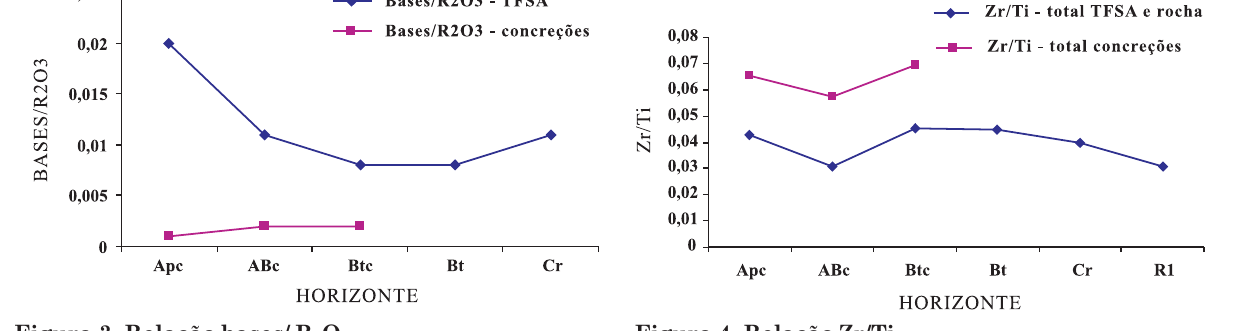
Figura 3. Relação bases/ R